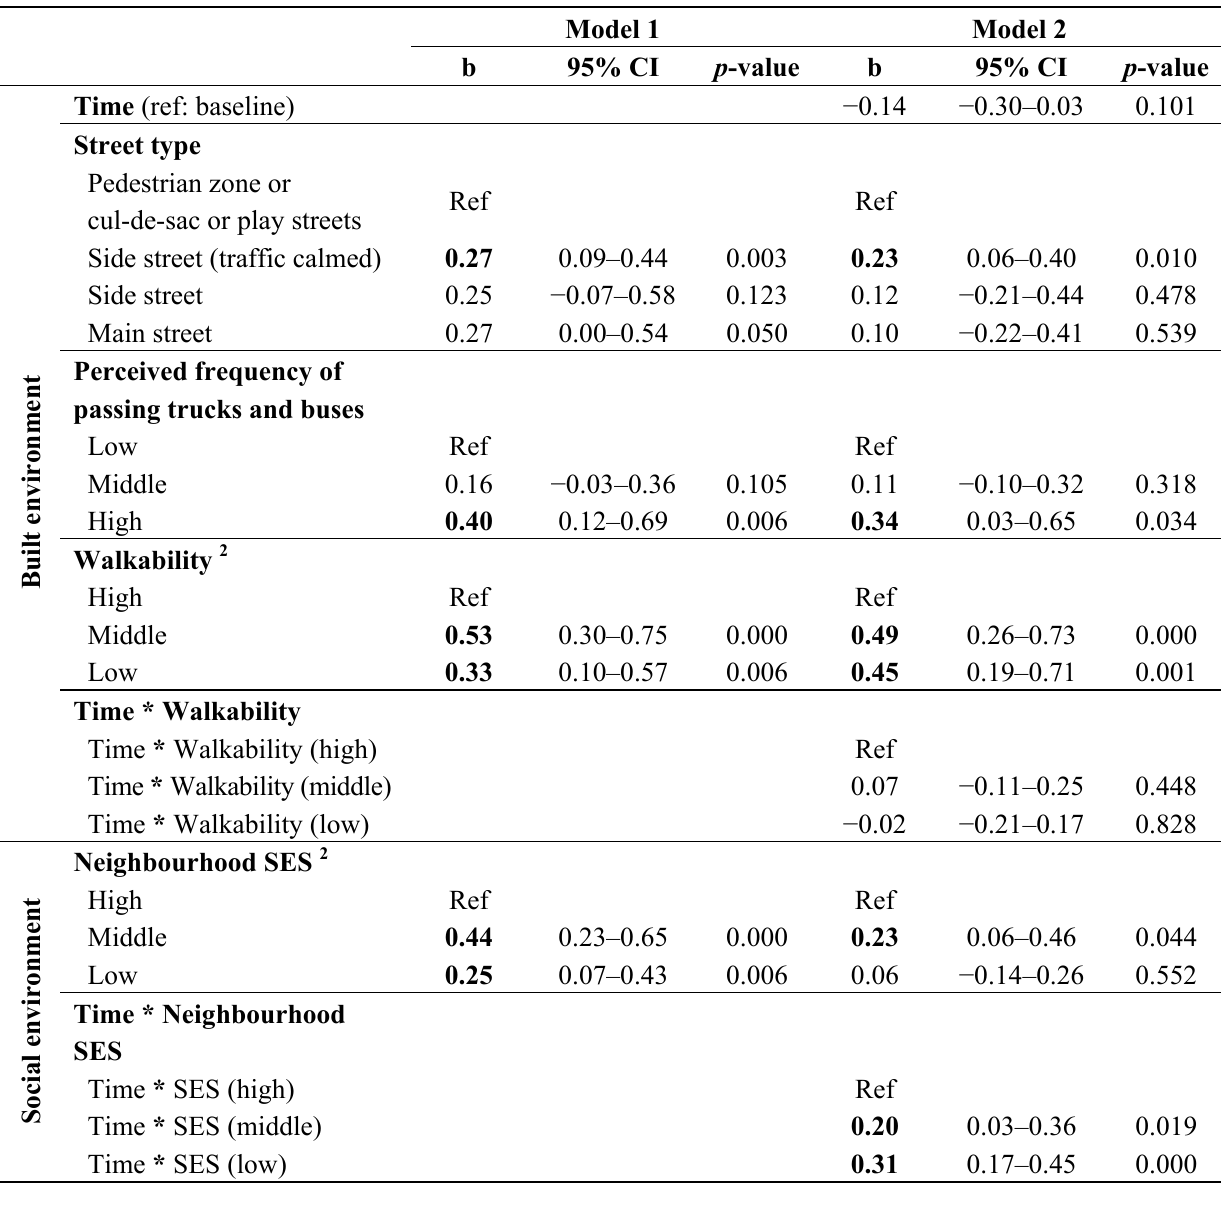
Table 4. Regression coefficients derived from GEE-analysis, investigating the longitudinal relationship between children’s BMI-SDS over 4 years (outcome variable) and neighbourhood built and social environment 1 . Bivariate and multivariate analysis and multivariate analysis (full